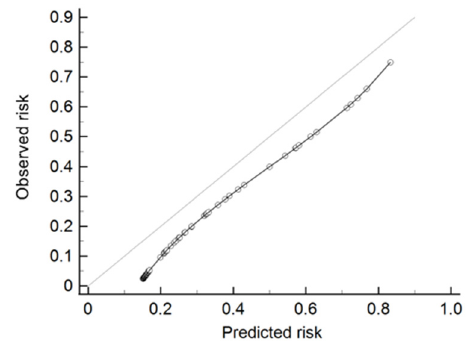
Figure 4. Calibration plot of the Martini nomogram.